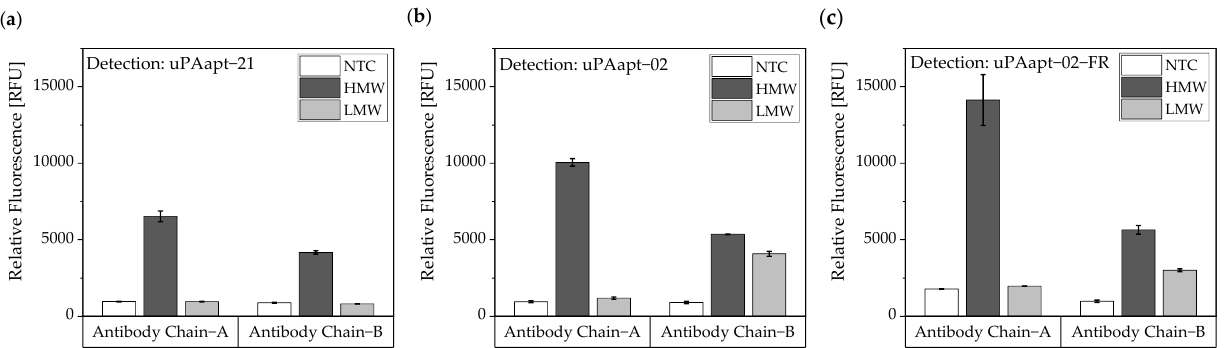
Figure 11. Antibody – Aptamer-based sandwich assay for detection and discrimination of HMW- and LMW-uPA. Antibodies (Ab Chain A or Ab Chain B) were used to capture the different forms of uPA. For detection, ( a ) uPAapt − 21 ( b ) uPAapt − 02 and ( c ) uPAapt − 02 − FR were used as reporter molecules. Whereas Ab Chain A can only capture HMW-uPA and therefore uPAapt − 02 or the truncated version uPAapt − 02 − FR can only detect the HMW-uPA form, the Ab Chain B captured the LMW-uPA form and uPAapt − 02 or uPAapt − 02 − FR bind LMW-uPA. The reporter aptamer uPAapt − 21 detected only HMW-uPA and showed no binding to LMW-uPA. The relative fluorescence unit [RFU] for each sample is given as the mean value of two technical replicates and was measured using the EnVision ® 2105 multimode plate reader. Error bars represent the range of measured values. NTC = No Target Control, HMW = HMW-uPA. Number of records n = 2.